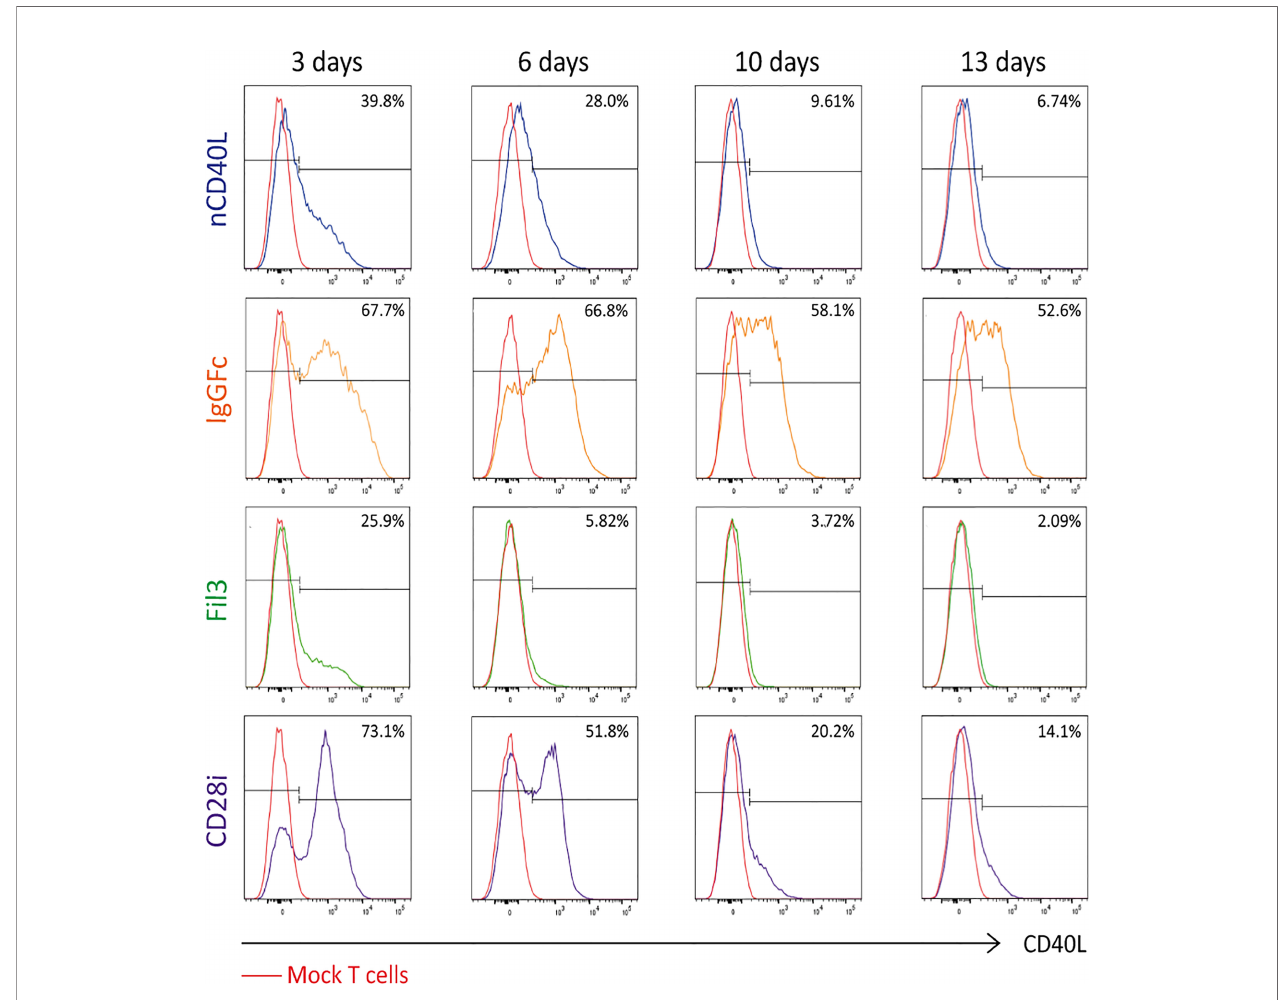
FIGURE 3 | CD40L:CD28 CSP surface expression kinetic in PBLs after retroviral transduction. Human primary T cells were retrovirally transduced with pMP71 encoding the CD40L:CD28 sequences and CSP surface expression was measured by fl ow cytometry at 3, 6, 10 and 13 days after transduction using CD40L antibody. Percentage of CD40L-positive cells within gated live, single, CD3 + populations are displayed as histograms. Mock-transduced T cells were used as negative control (red line), T cells transduced with the native CD40L (nCD40L) protein were used as expression reference and are depicted in blue, CD40L:IgGFc: CD28 CSP is depicted in orange, CD40L:Fil3:CD28 CSP is depicted in green and CD40L:CD28i CSP is depicted in purple. Shown is one representative experiment of at least 5 repeats. A summary graph of 5 experiments is shown in Supplementary Figure 1